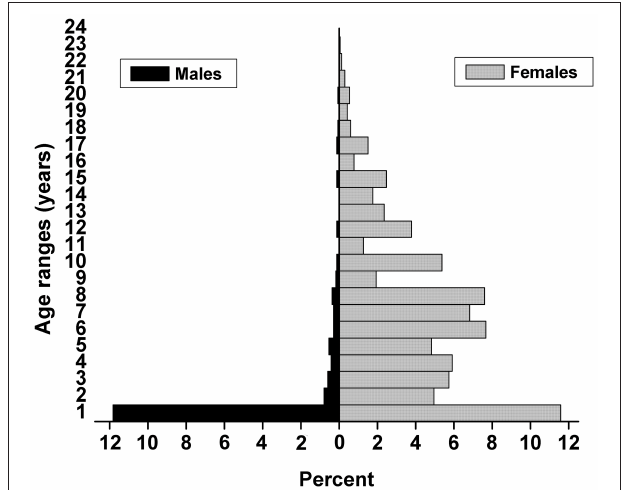
FIGURE 2 | Overall age distribution of the donkeys by gender in Western Liaoning and Eastern Inner Mongolia of China ( n = 1,658).